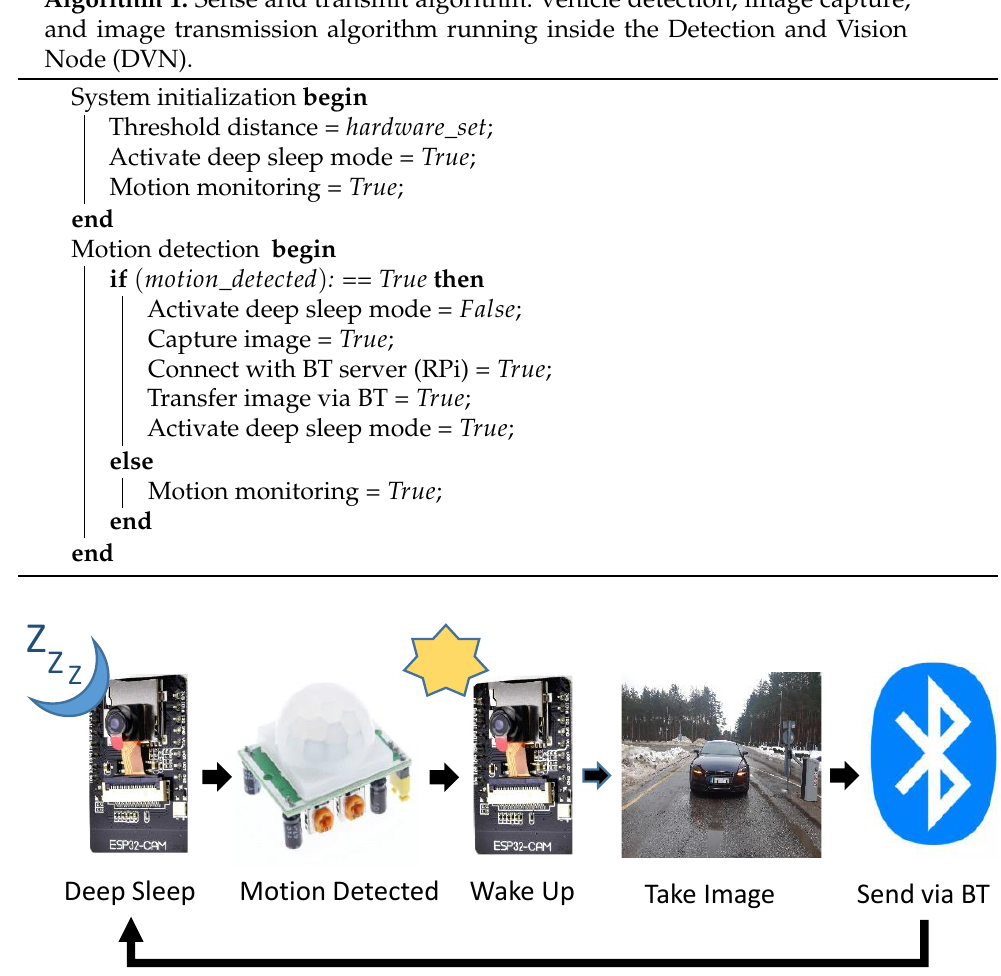
Algorithm 1: Sense and transmit algorithm: vehicle detection, image capture, and image transmission algorithm running inside the Detection and Vision